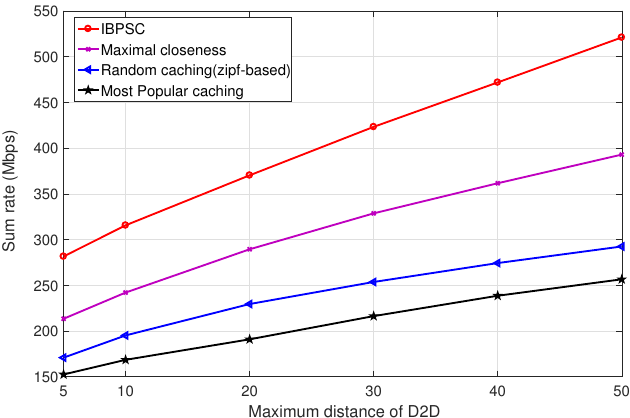
Figure 10. Sum rate vs. maximum D2D communication